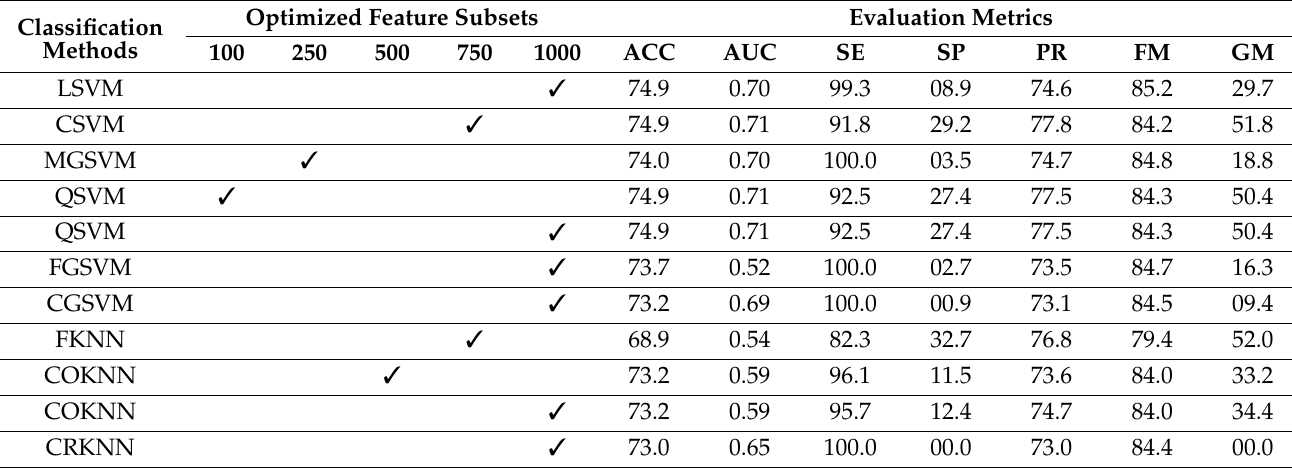
Figure 5. Fitness values of ACS-based optimization with ( a ) 100-feature, ( b ) 250-feature, ( c ) 500-feature, ( d ) 750-feature, and ( e ) 1000-feature subsets. Table 6. Front view-based experimental results on MIT